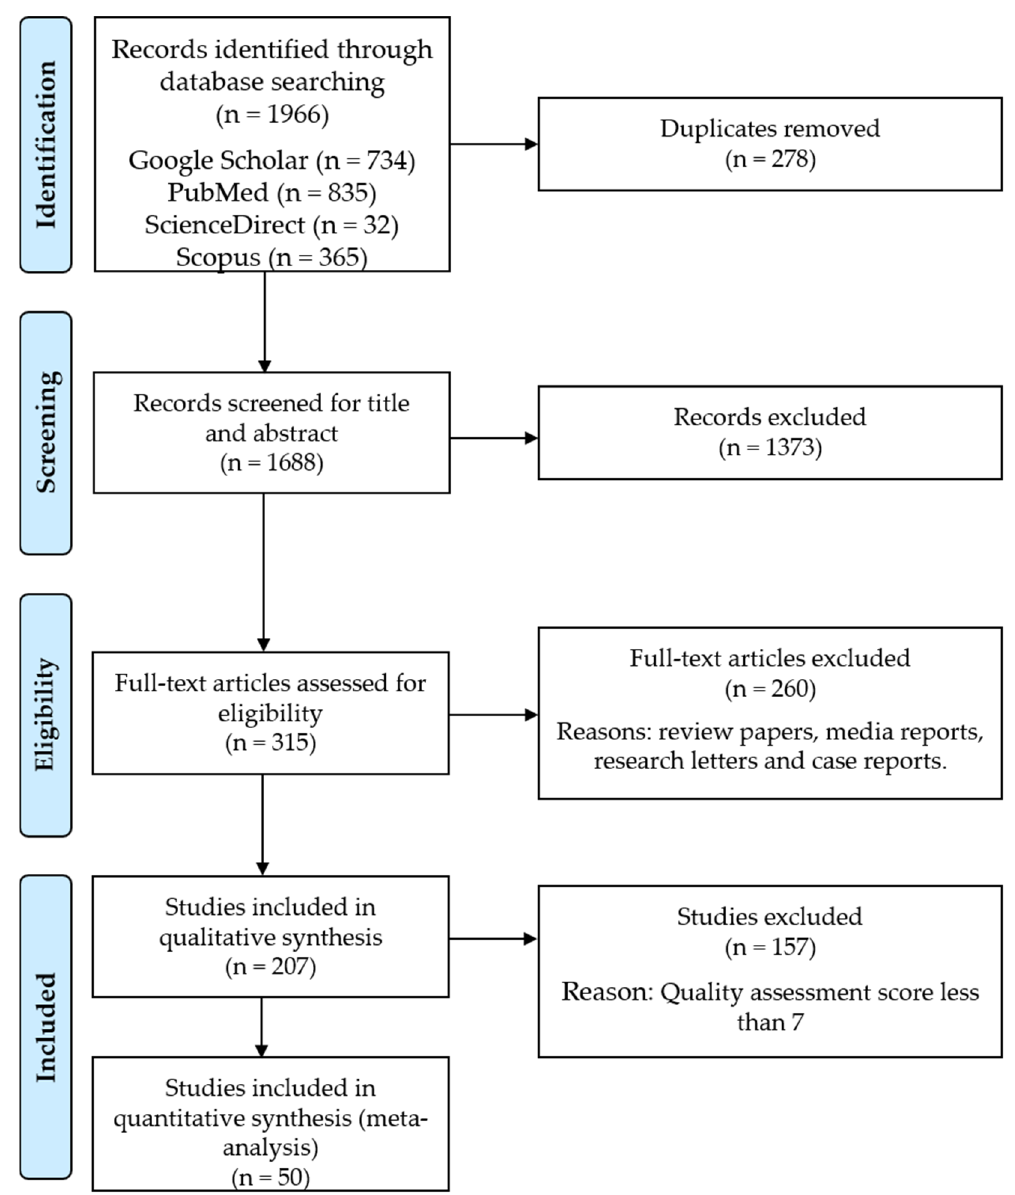
Figure 1. PRISMA flowchart illustrating the process of identifying, screening and selecting the eligible articles in this study.